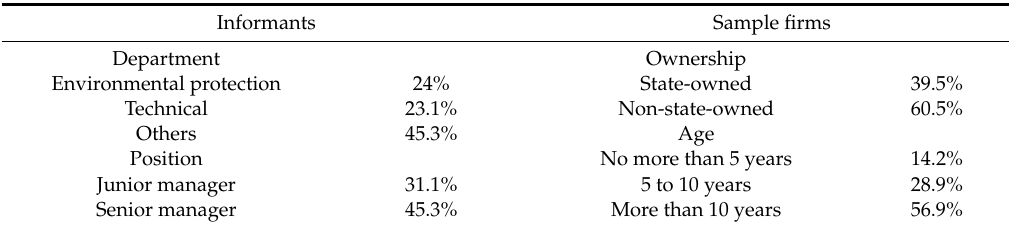
Table A1. Demographic traits of informants and sample firms